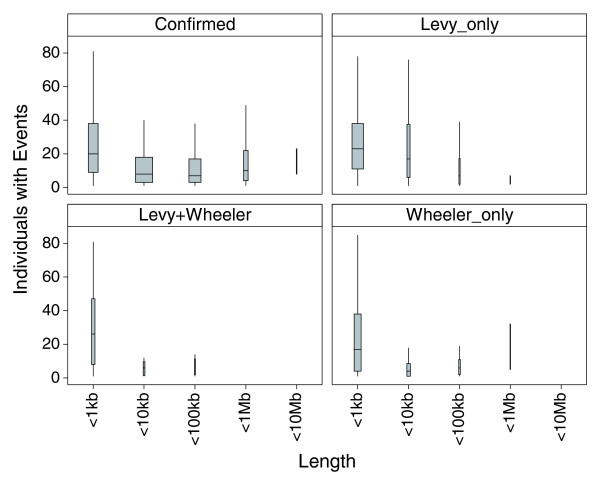
Breakdown of event occurrence tallies by region lengths. Panels correspond to confirmed CNVs from our work, and regions discovered by whole-genome sequencing as summarized in Table 4. Box-plots show medians and interquartile ranges, with whiskers extending to maximum or minimum values within 1.5 times the 75th or 25th percentiles, respectively. The width of boxes is proportional to the number of regions.